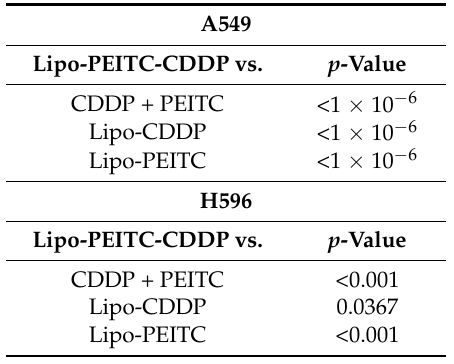
Table 5. Effect of liposomes containing both phenethyl isothiocyanate (PEITC) and cisplatin (CDDP) (Lipo-PEITC-CDDP) on cancer cell lines.